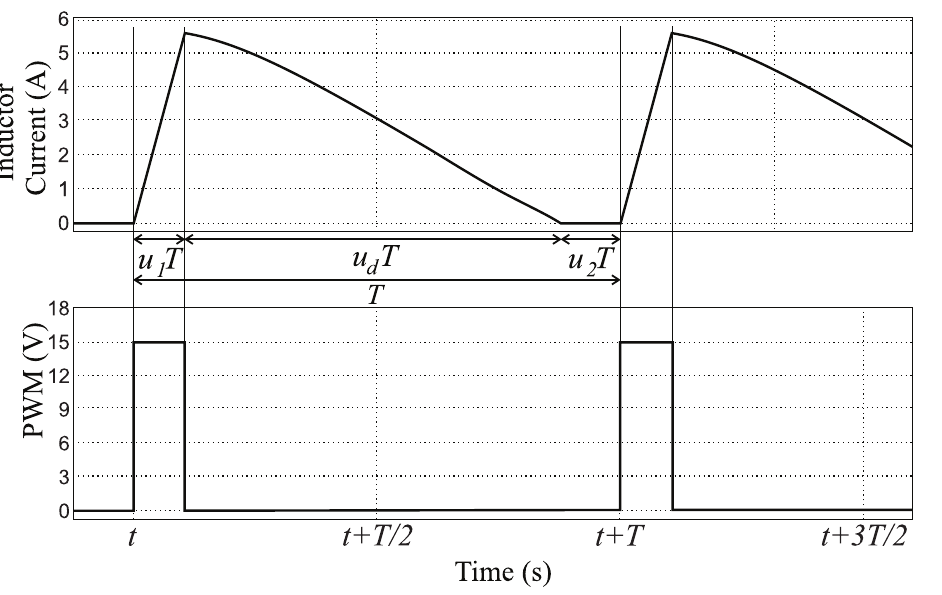
Figure 5. Exemplification of the inductor current behavior in DCM concerning the triggering on Q . PWM stands for the voltage signal in the gate